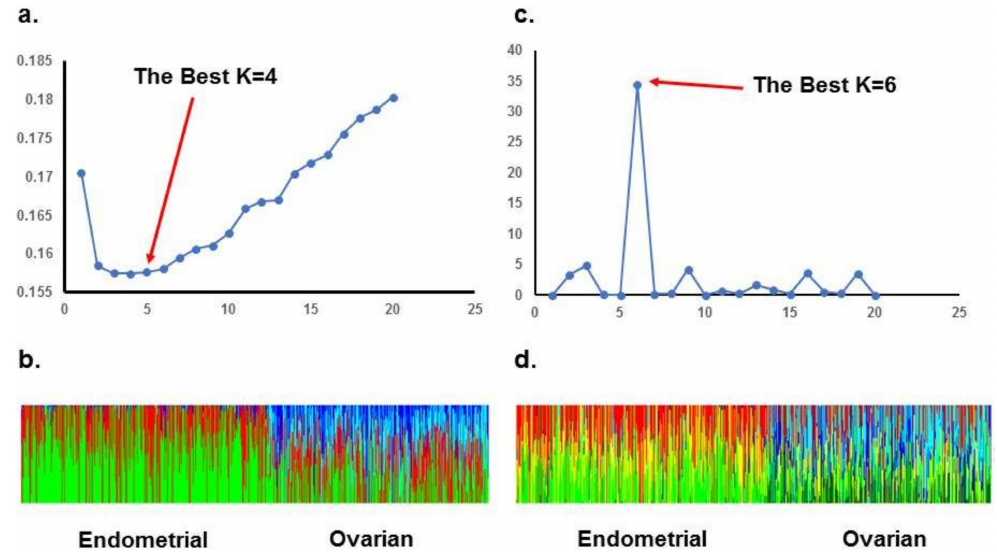
Figure 2. STRUCTURE and ADMIXTURE subpopulations structure analysis of TCGA patients: ( a ). ADMIXTURE analysis: Cross-validation error is minimal when K = 4; ( b ). Bar plot of admixture results for admixture proportions organized by origin of tumor; ( c ). STRUCTURE analysis: K methods shows a best K = 6; ( d ). Bar plot of STRUCTURE results for admixture proportions organized by origin of